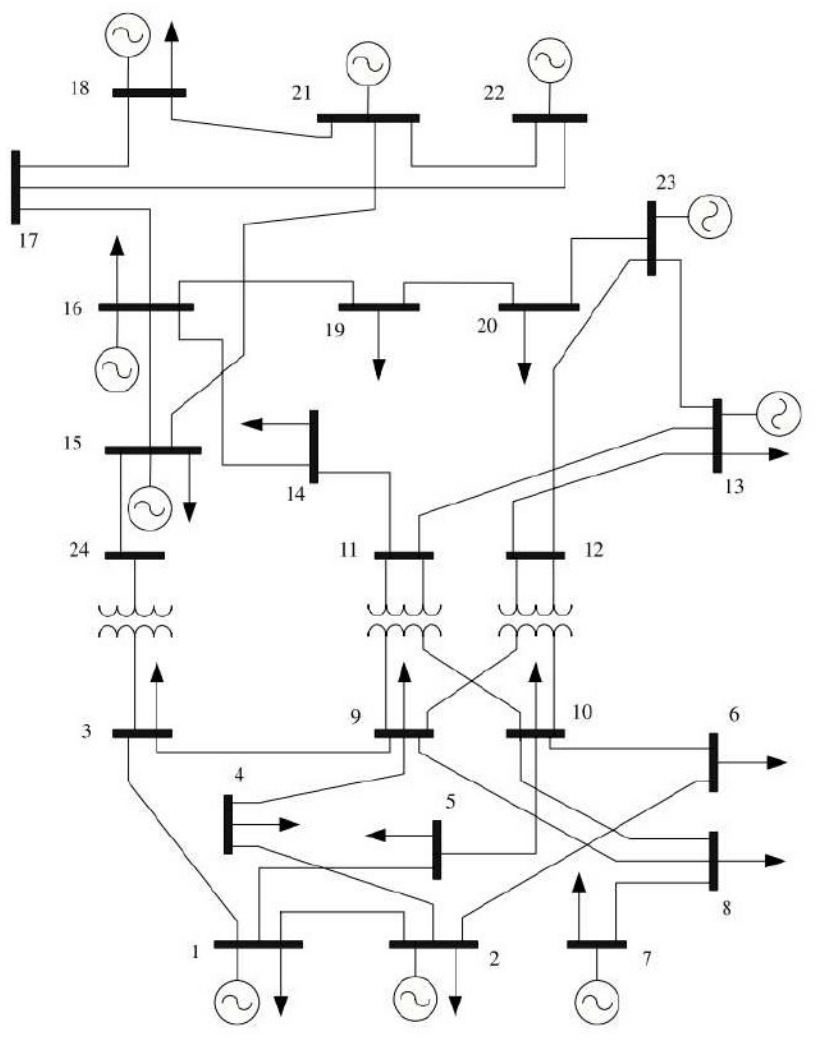
Figure 3. IEEE 24 bus reliability test system